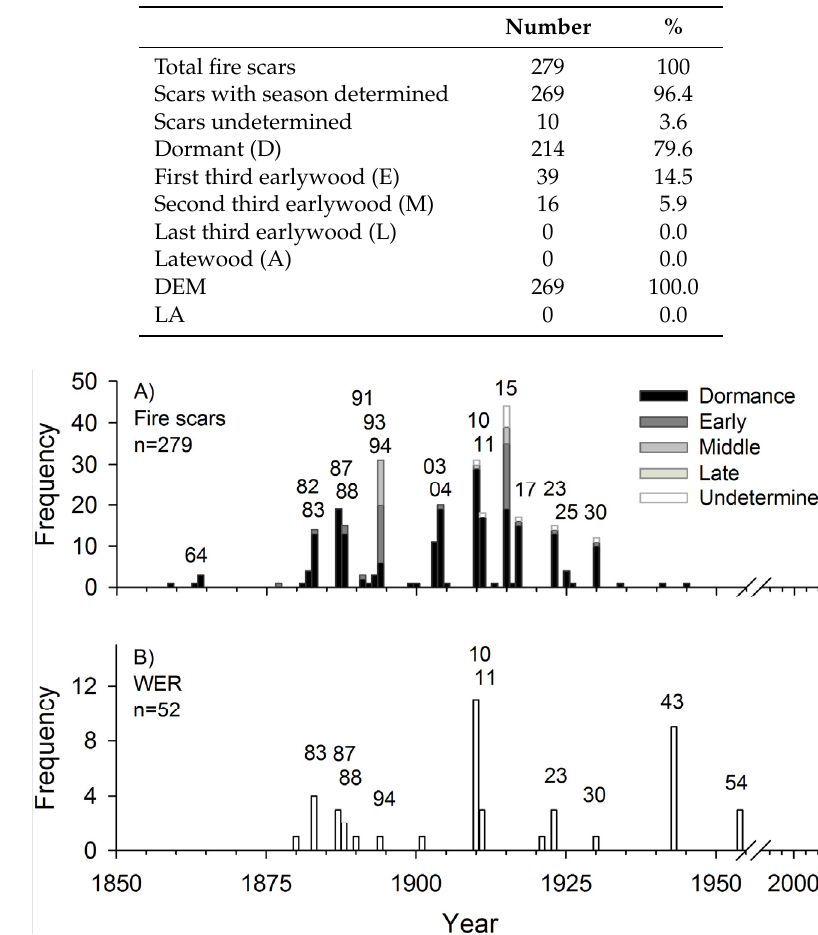
Figure 7. Frequency of fire scars with location within tree rings ( A ) and of white earlywood rings ( B ). The break in x ‐ axis from 1955–1989 is simply intended to better capture the figure’s details.